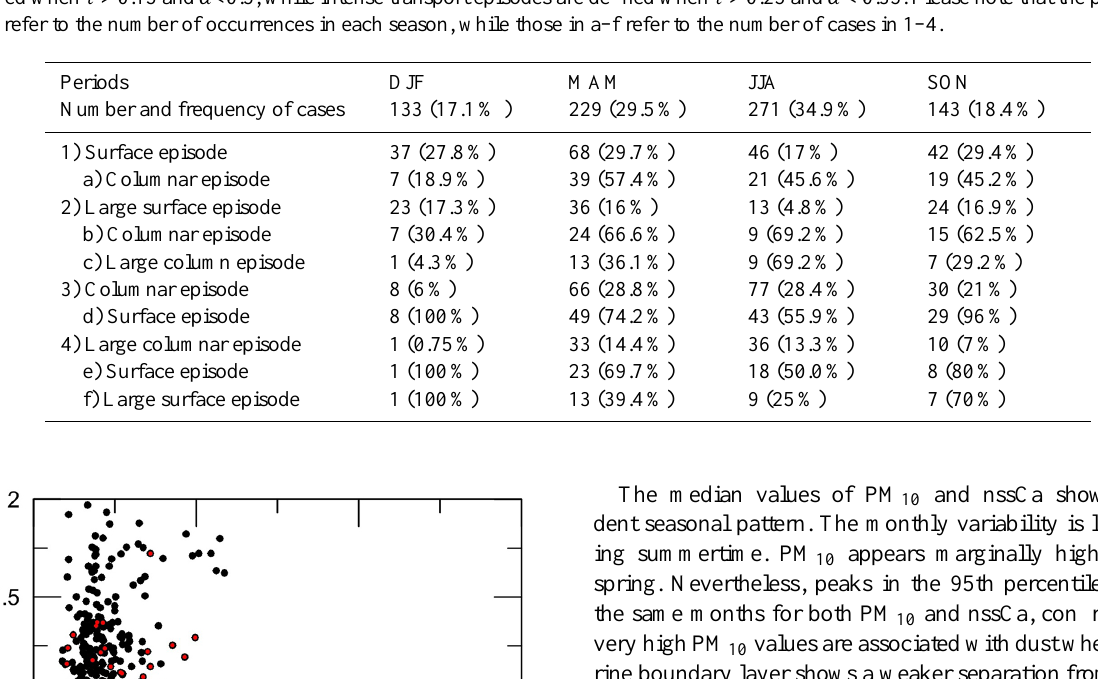
Table 3. Seasonal occurrence of different transport scenarios identified on the basis of nssCa on PM 10 and τ and α from optical measure- ments. The number of cases and the percent with respect to the total number of PM 10 measurements are reported for each season. Four criteria (1 through 4) to detect dust presence in the column and at surface are established, while their combination is used to identify six possible scenarios (a through f) of dust transport. Surface and large surface desert dust episodes correspond to values of nssCa larger than 483 and 2*483ngm − 3 , respectively. Episodes characterized by the dominant presence of desert dust aerosol on the atmospheric column are identified when τ >0.15 and α <0.5, while intense transport episodes are defined when τ >0.25 and α <0.35. Please note that the percentages